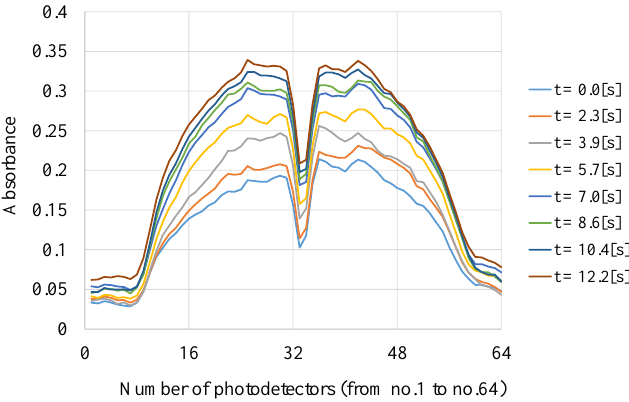
Figure 4. Change of the absorbance when the acidic culture medium is gradually changed to alkaline.